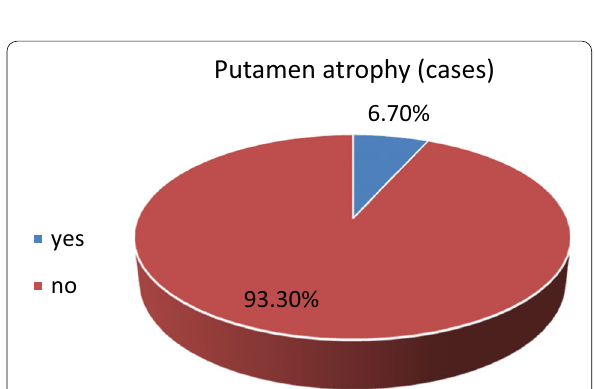
Fig. 6 Diagrammatic representation of percent of patients with putamen atrophy